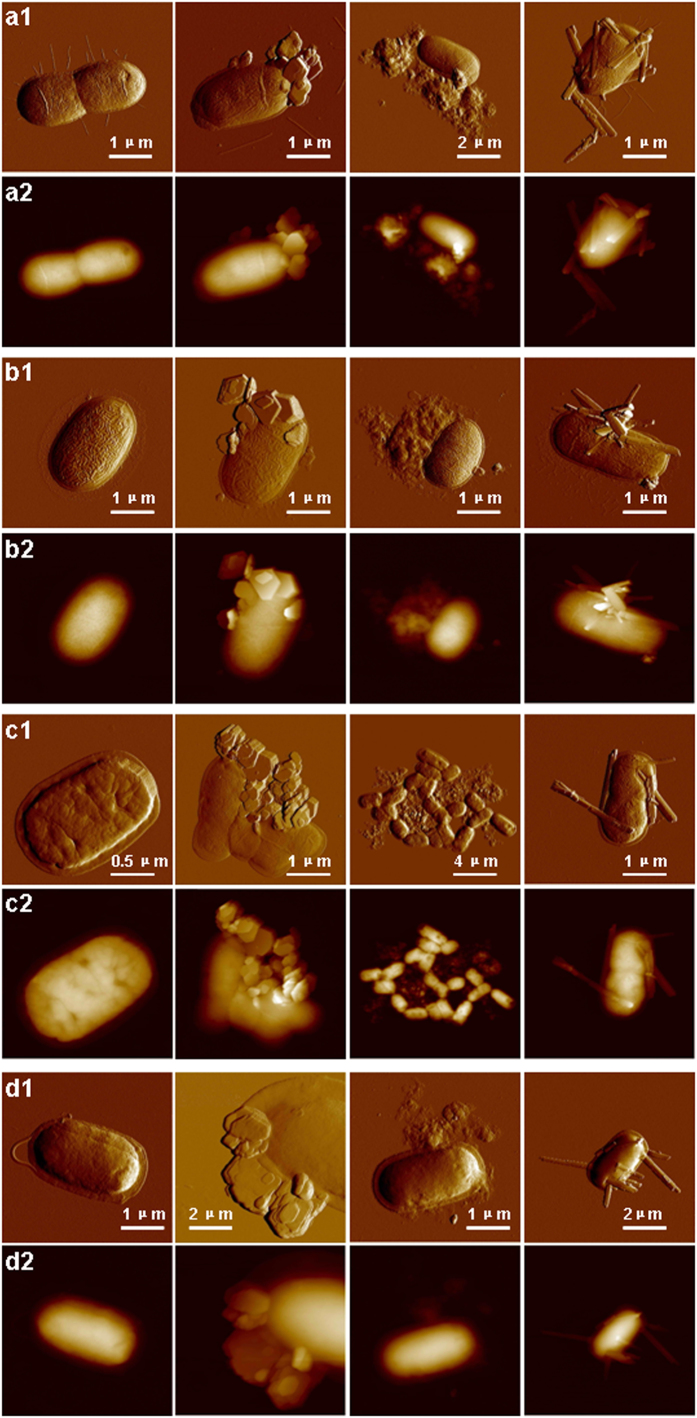
AFM images of bacteria and their aggregates with minerals in air.Peak force error and height images of E. coli (a1,a2), P. putida (b1,b2), A. tumefaciens (c1,c2), B. subtilis (d1,d2) and their aggregates with kaolinite (the second column), montmorillonite (the third column), and goethite (the fourth column).